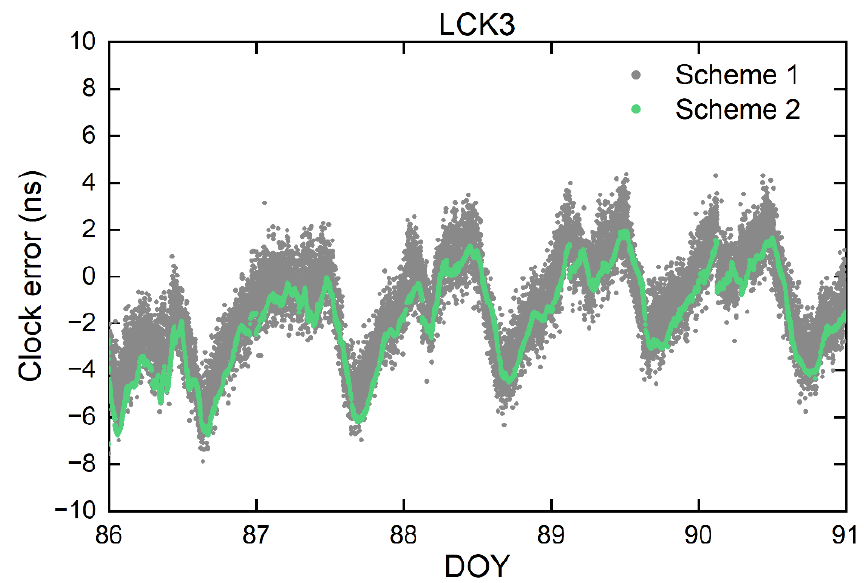
Figure 8. Receiver clock error sequence of LCK3 station.